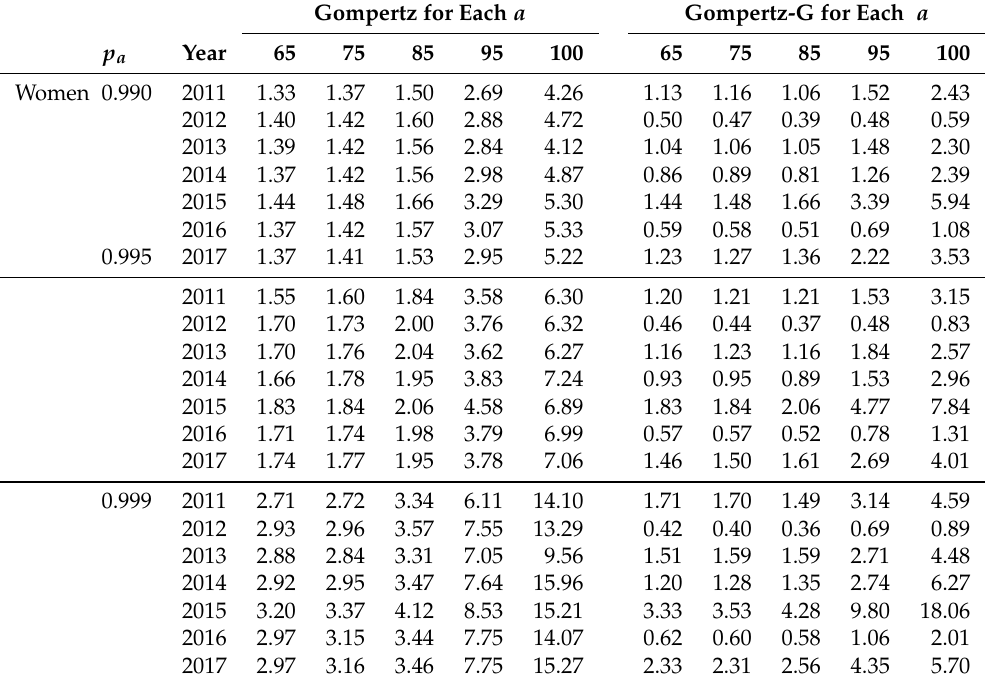
(upper table) and “tail premium”, a